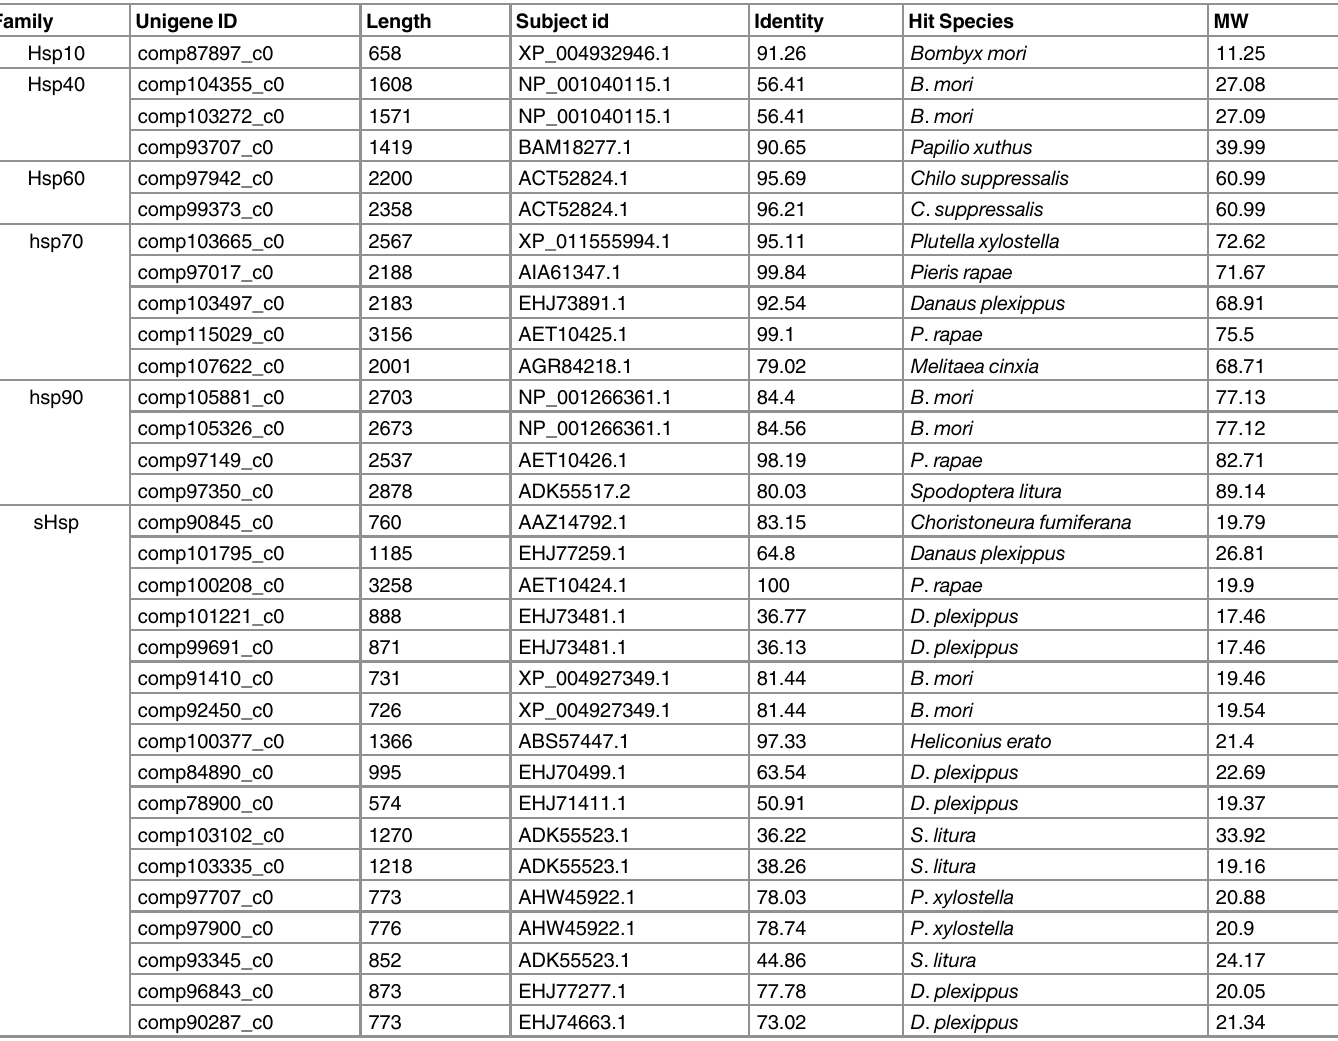
Table 5. Putative identified heat shock protein genes with complete open reading frame.